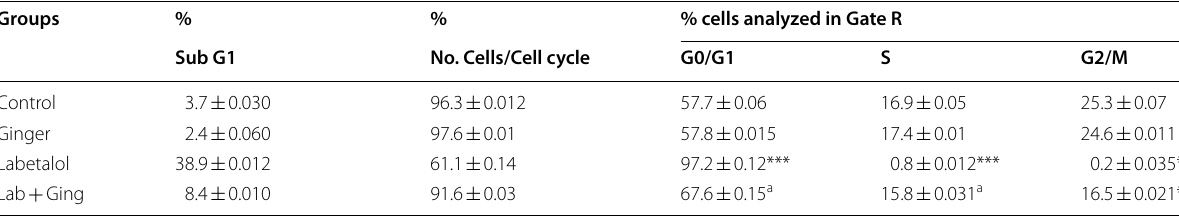
Data are shown as the mean The P value in comparison with the control group is indicated by an asterisk (*** P < 0.001, * P < 0.05) (a) is highly significantly ( P < 0.001) different from the labetalol group